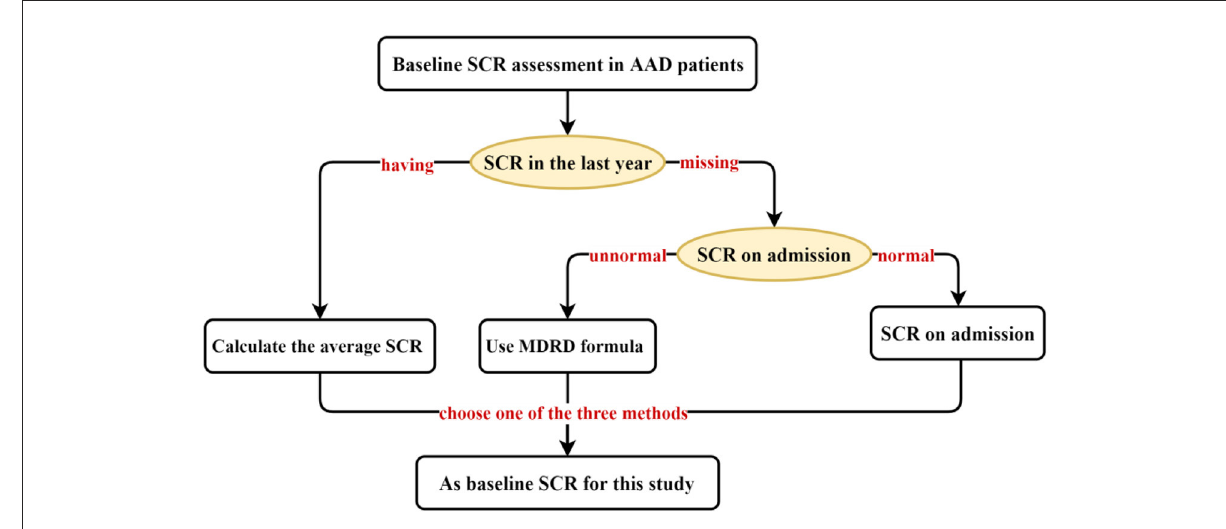
FIGURE1 Baseline creatinine assessment method for patients with